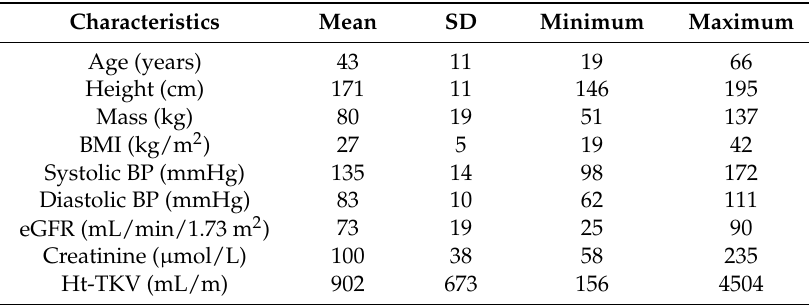
Table 1. Baseline characteristics of the study population ( n =